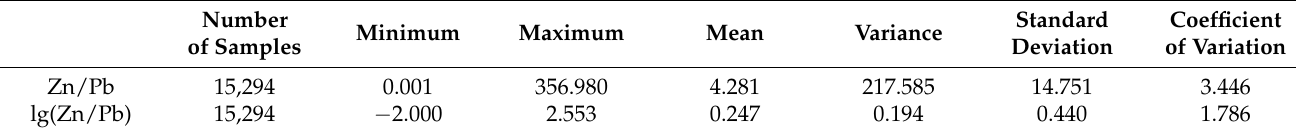
Table 4. Statistical characteristics of Zn/Pb and lg(Zn/Pb).